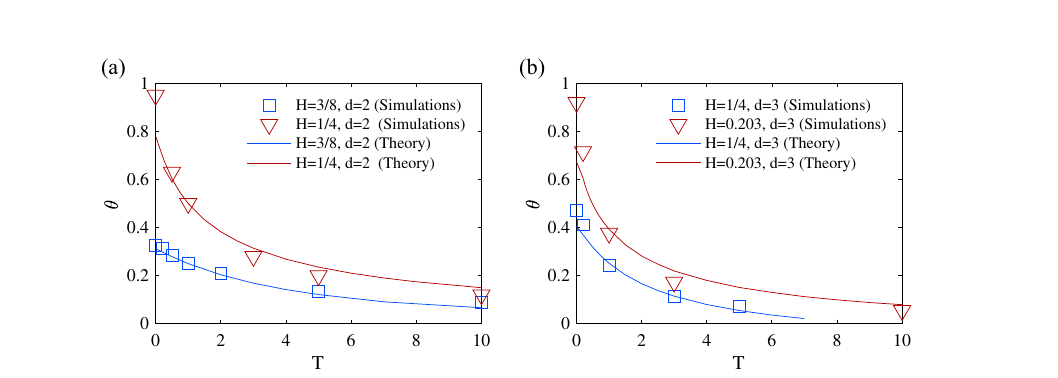
Fig.3|Persistenceexponentsindimensionshigherthanone.a d =2and b d =3. These results are obtained when the random walker is a tagged monomer in dif- ferent polymer models: semi- fl exible chains ( H =3/8), fl exible chain without